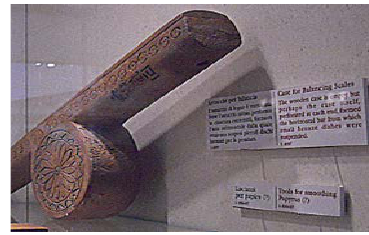
Figure4-5 Comparison between contemporary compass and Kha's protractor. Figure4-6 Kha's protractor, 18th